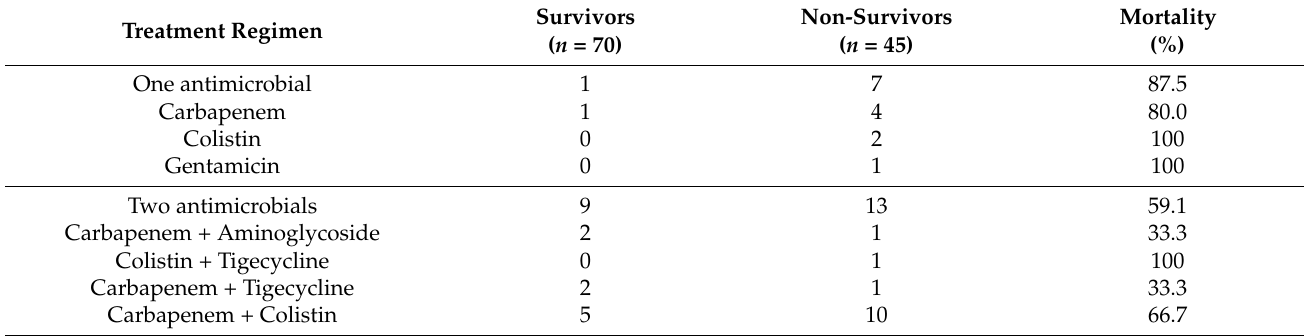
Table 3. Types of antimicrobial treatment and the associated 30-day